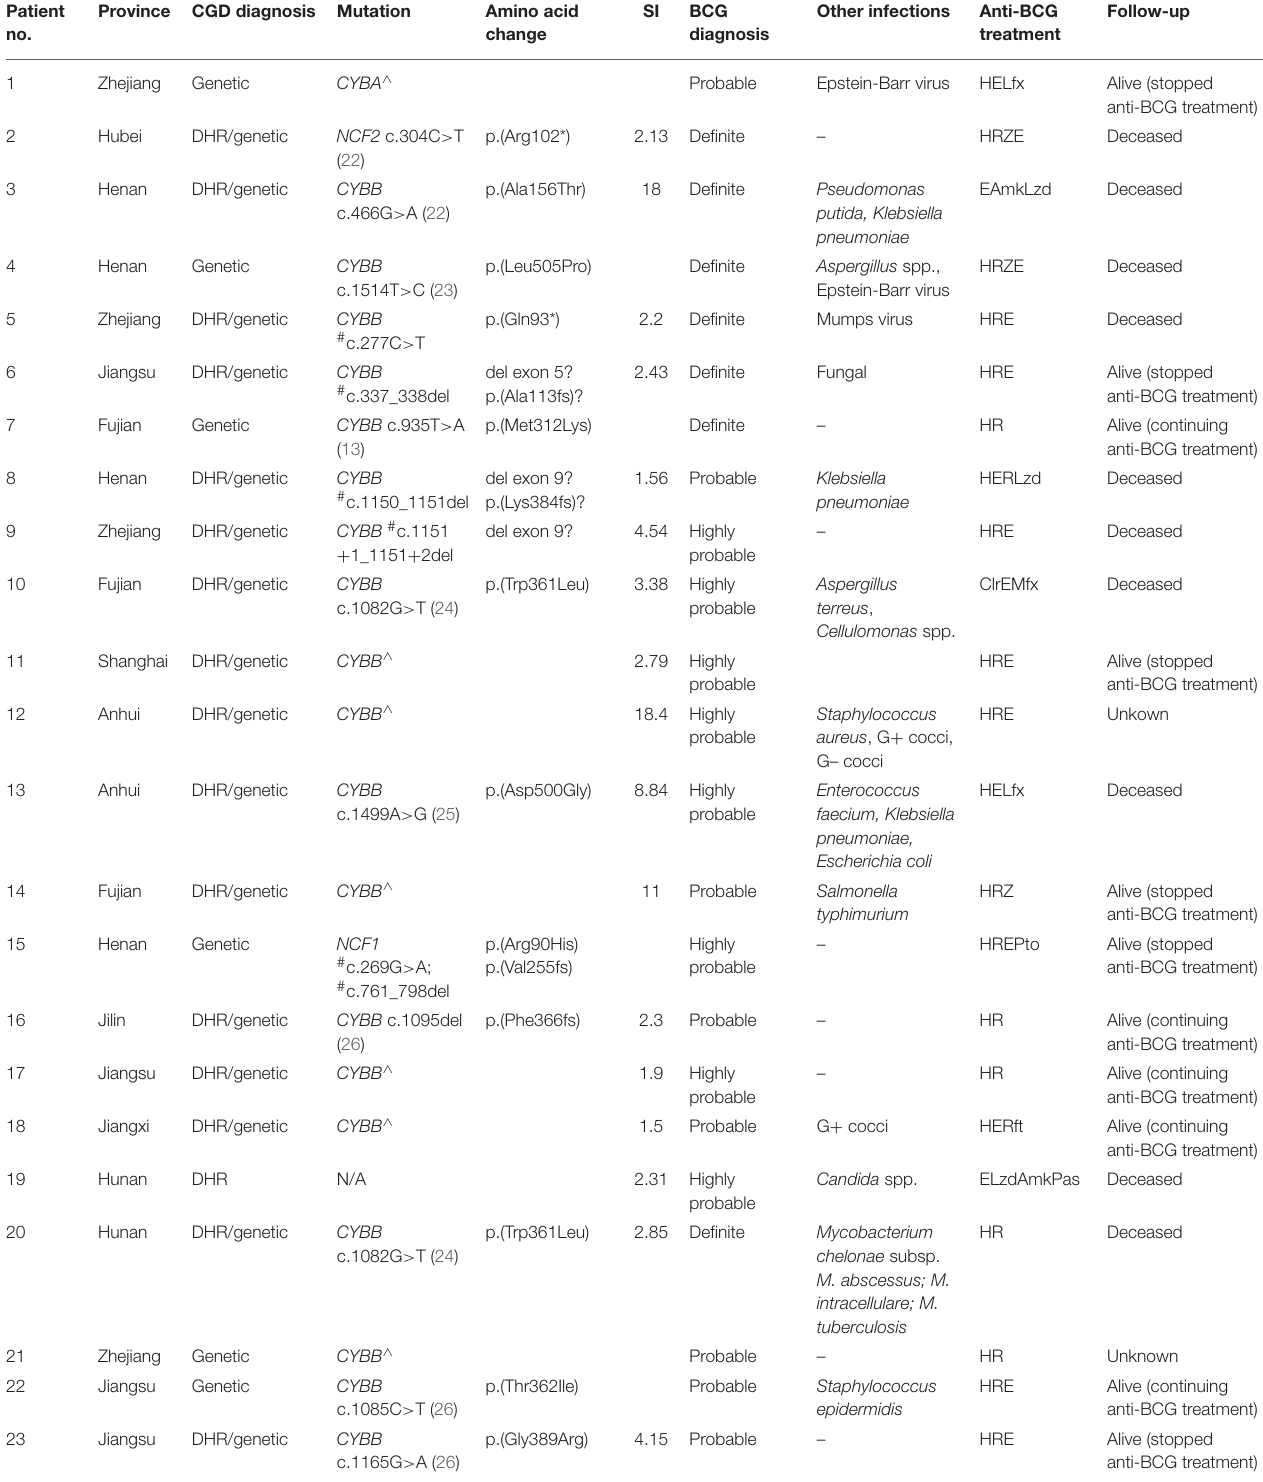
TABLE 3 | The cohort’s clinical and genetic characteristics. Patient